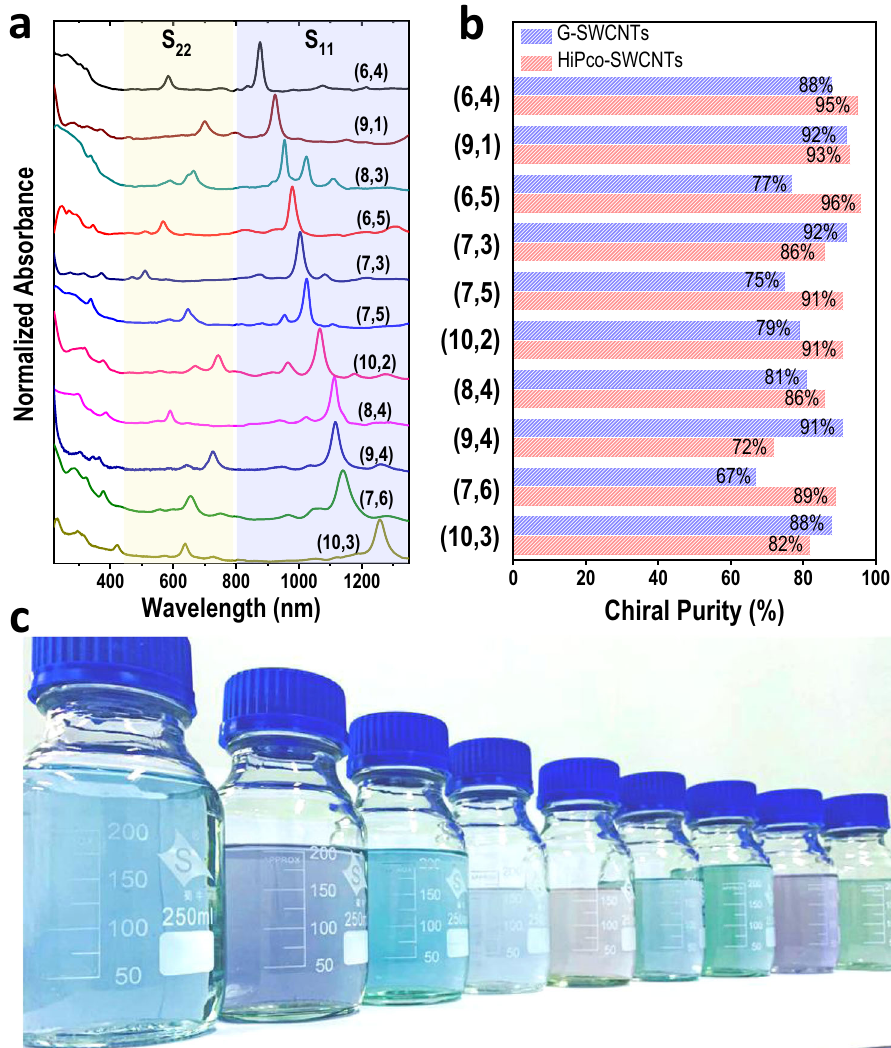
Fig. 4 | Submilligram-scale separation of single-chirality species from high- concentration G-SWCNTs. a Optical absorption spectra and b statistical purity distribution of the separated single-chirality SWCNTs. c Photograph of the